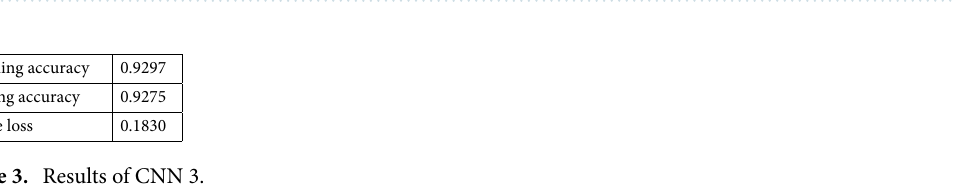
Figure 16. ROC curve of CNN2.